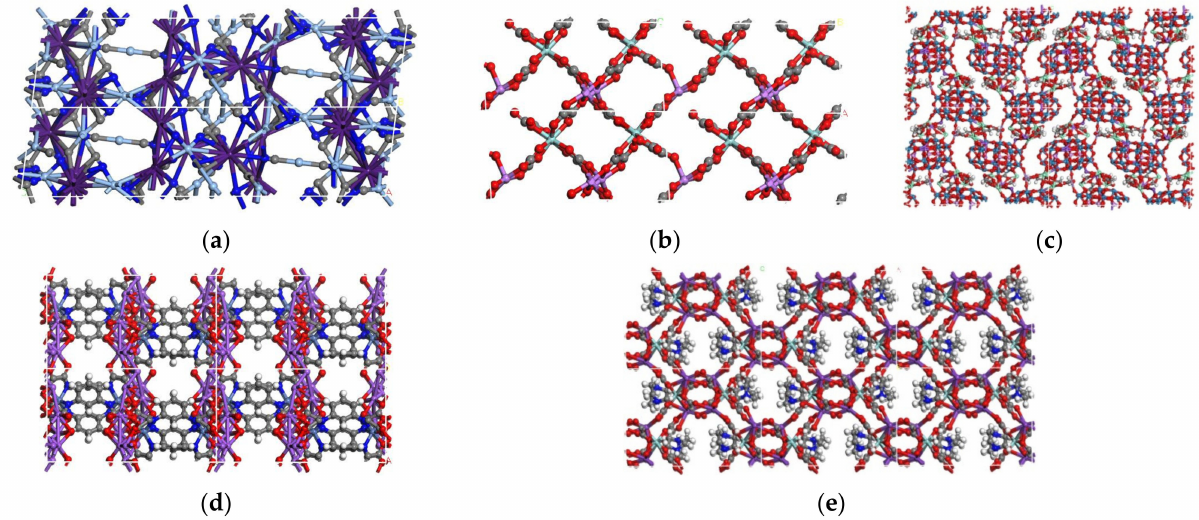
Figure 5. Atomistic structures of top-performing MOFMs. ( a ) CARGEI; ( b ) YUJWAD; ( c ) RIPWEU; ( d ) VEHNED; ( e )